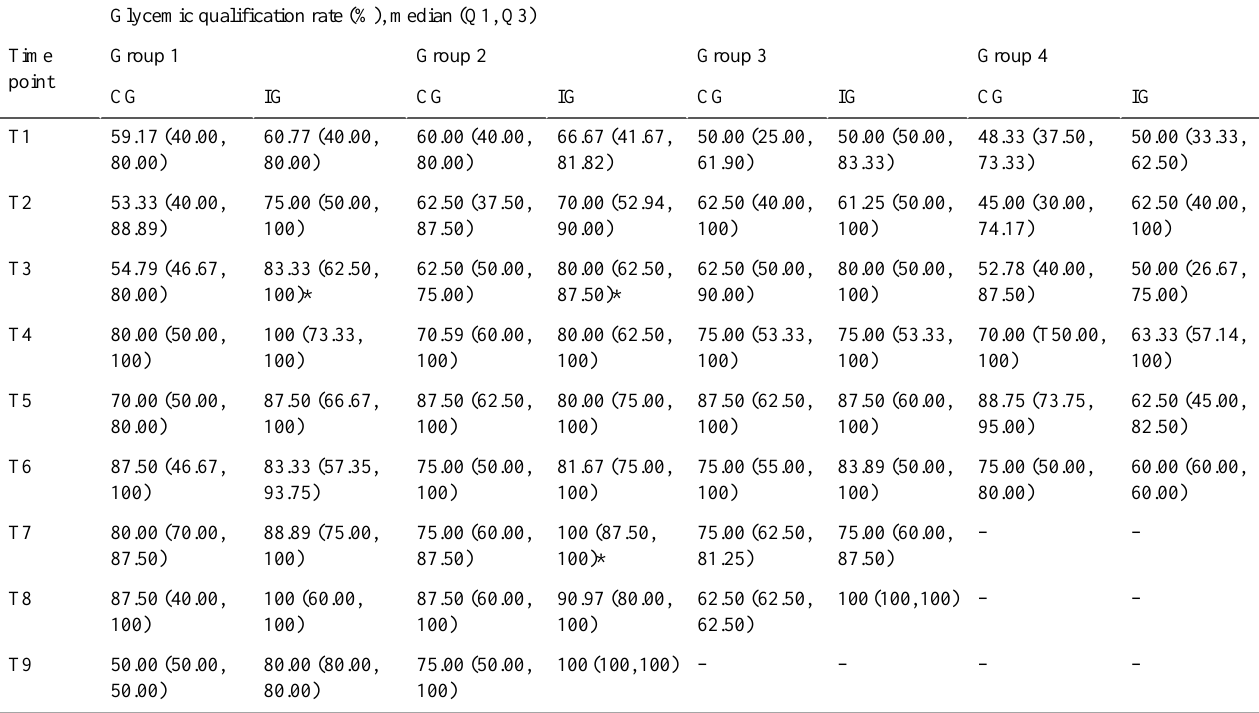
Table 2. Glycemic qualification rate of the control group (CG) and intervention group (IG) according to gestational weeks at enrollment. Glycemic qualification rate (%), median (Q1,